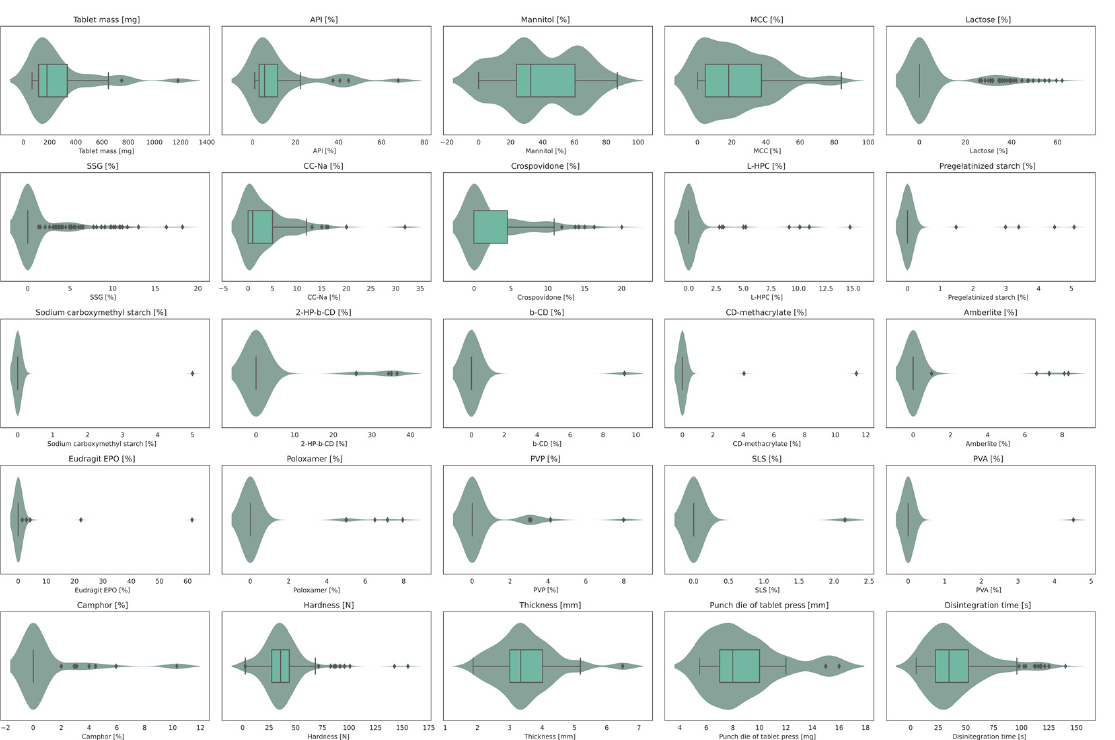
Figure 2. Correlation matrix of the database.